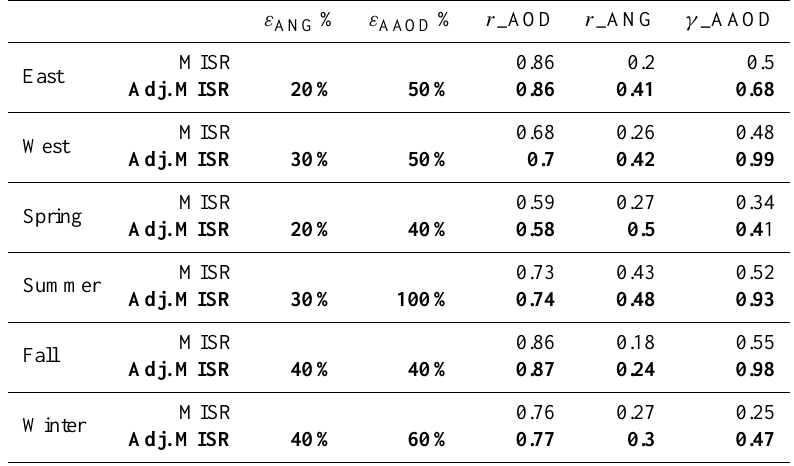
Table 2. The correlation coefficients (for AOD and ANG) and mean ratio (for AAOD) between MISR, our result (in the specific thresholds), and AERONET. ε ANG % ε AAOD % r _AOD r _ANG γ _AAOD MISR 0.86 0.2 0.5 East Adj. MISR 20% 50% 0.86 0.41 0.68 MISR 0.68 0.26 West Adj. MISR 30% 50% MISR Spring Adj. MISR MISR Summer Adj. MISR MISR Fall